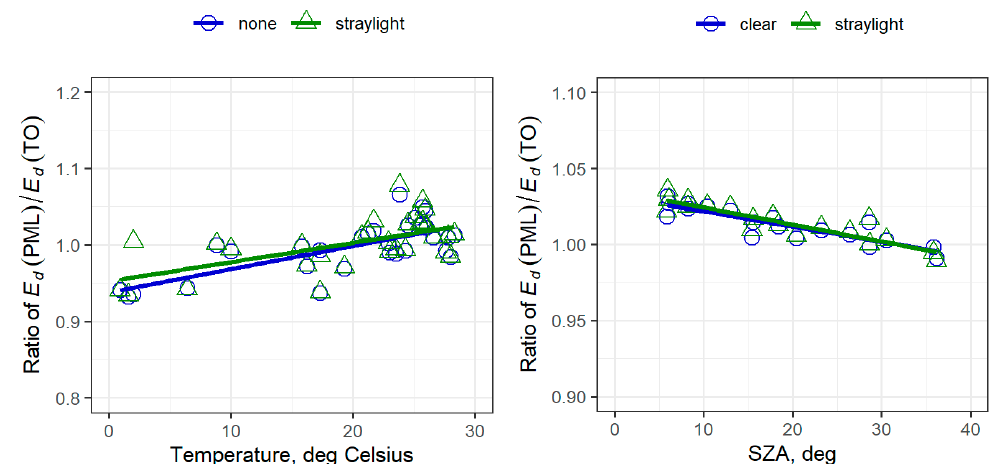
Figure 5. The difference in downwelling irradiance between PML (Plymouth Marine Laboratory) and TO (Tartu Observatory) as a function of ambient temperature (left panel) and function of Solar Zenith Angle (right panel). Blue color circles represent data without any correction and with green triangles after straylight correction.